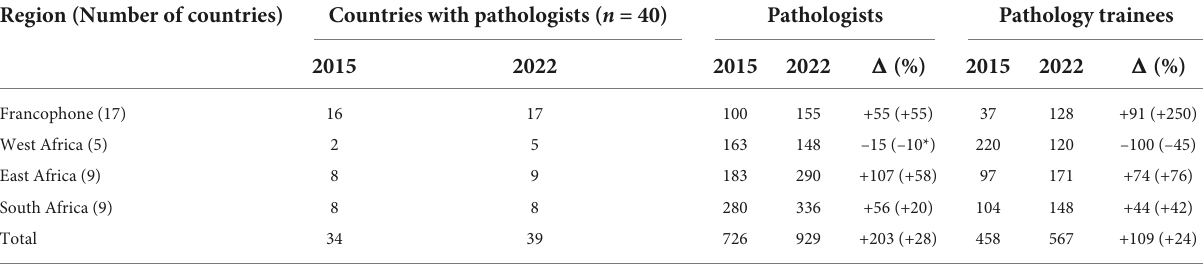
TABLE 1 Change in pathologists and pathology trainees from 2015 to 2022. Region (Number of countries) Countries with pathologists ( n =